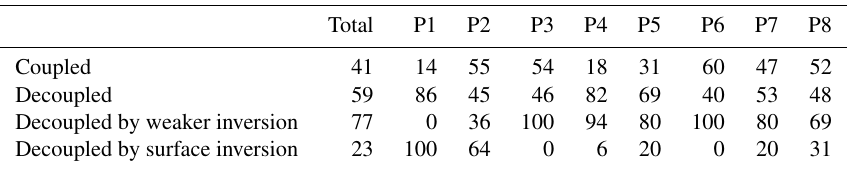
Figure 13. Median profiles of (a) equivalent potential temperature, (b) RHw, and (c) wind speed for the eight key periods of the campaign. Table 3. Percentage of coupled and decoupled boundary layer conditions for the whole campaign and for the eight key periods. Furthermore, the relative amount of the decoupling type is given – either by a weaker inversion below the main inversion or by the BL being stable, meaning decoupling by a surface